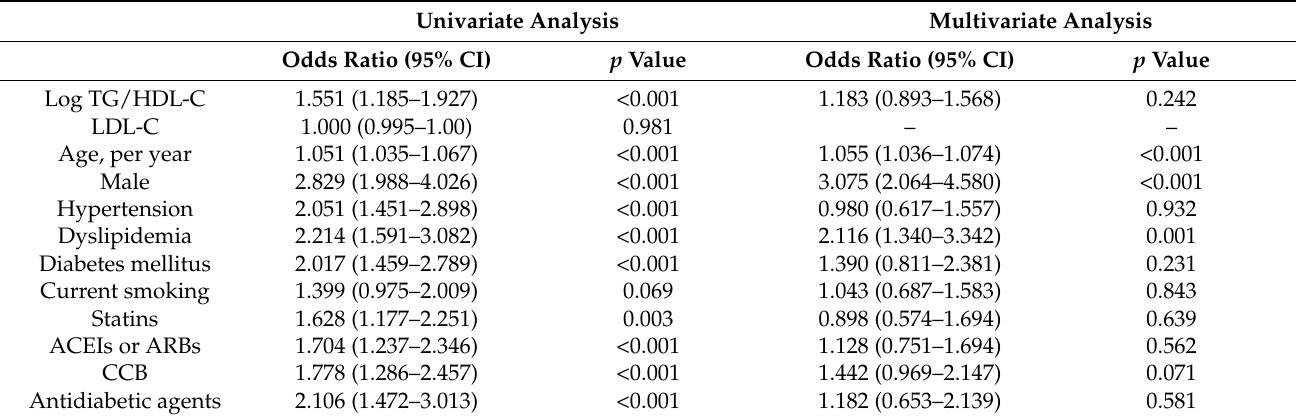
Table 4. Univariable and multivariable associates of significant